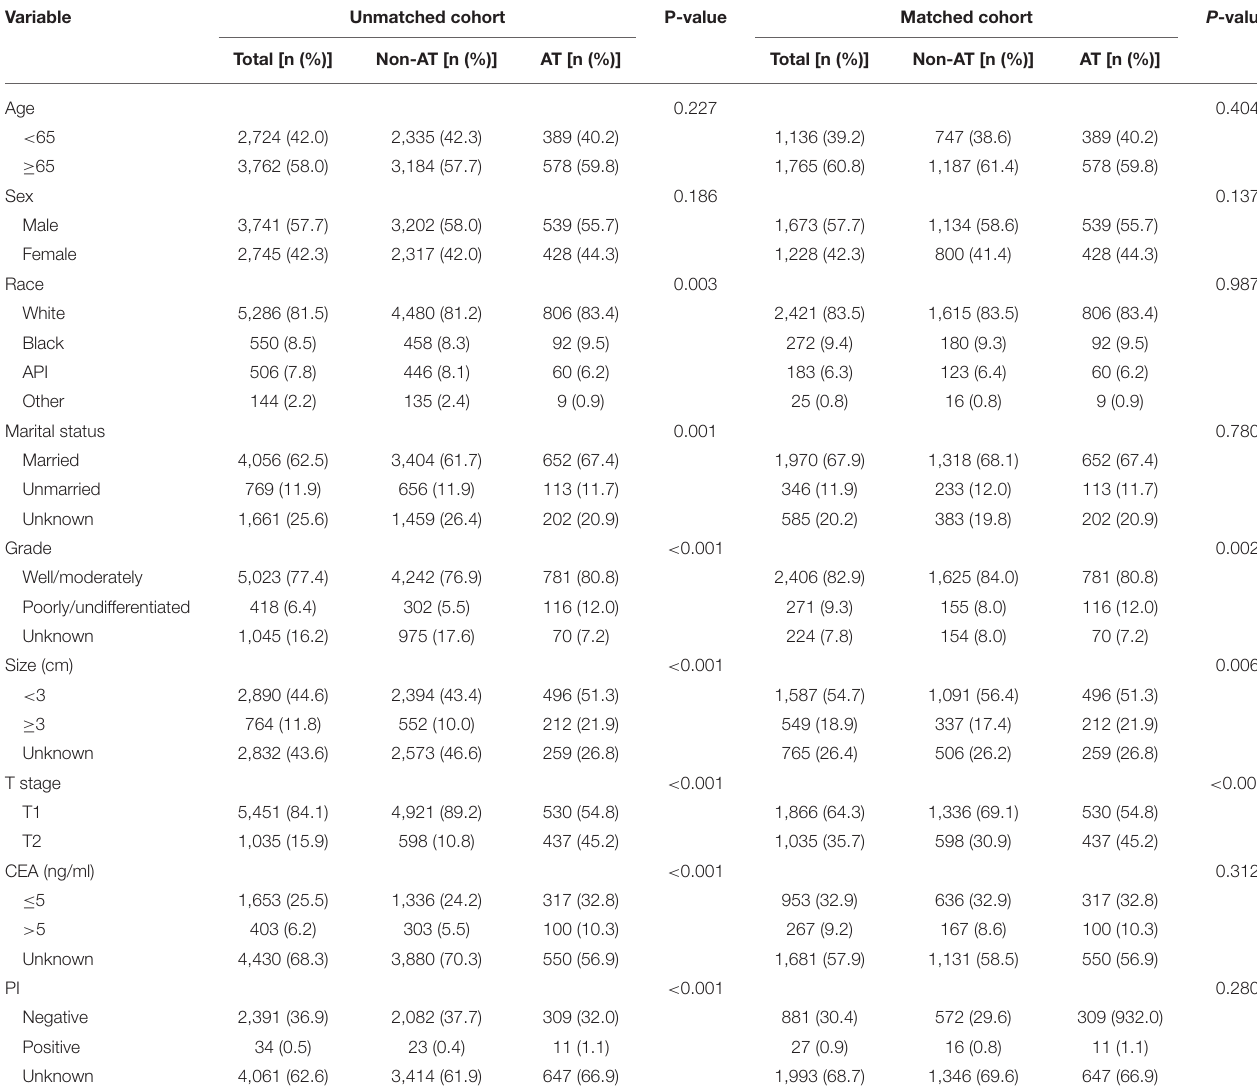
TABLE 1 | Characteristics of